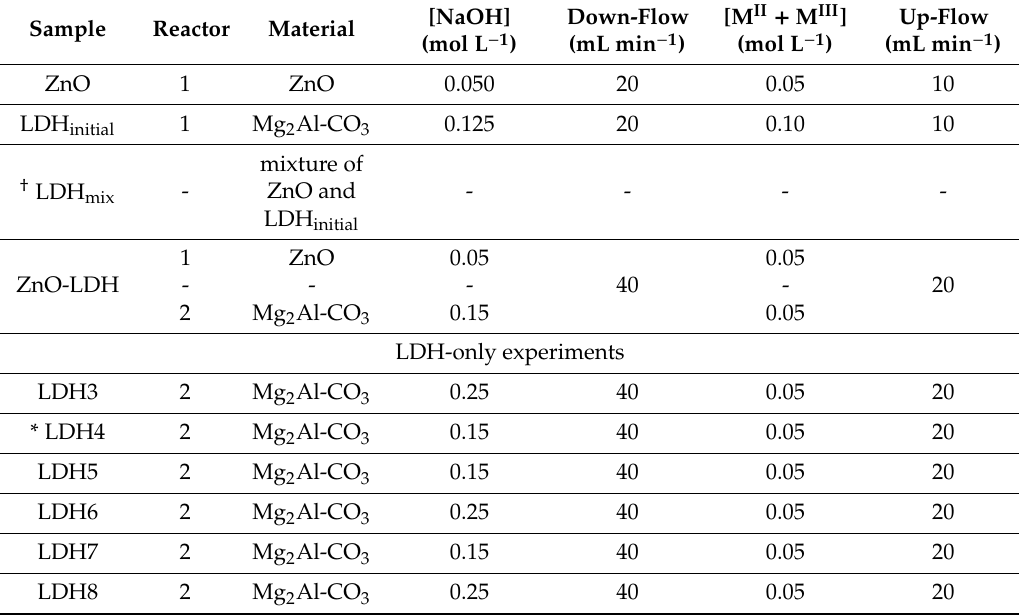
Table 1. Synthesis conditions for layered double hydroxides (LDHs) and